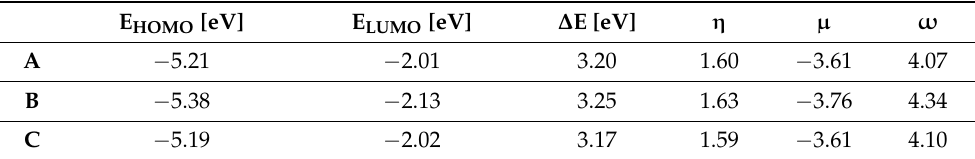
Table 2. Chemical hardness ( η ), chemical potential ( µ ) and global electrophilicity indexes ( ω ) of molecules A – C .